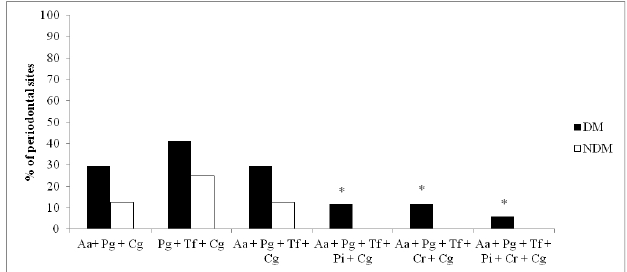
Fig. 3 - Frequency of periodontal sites (%) harboring combinations of putative periodontopathogens with Candida glabrata (Cg) in the DM and NDM groups. *Statistically significant differences between the DM and NDM groups, according to χ2 tests (p <0.05). Aggregatibacter actinomycetemcomitans (Aa), Porphyromonas gingivalis (Pg), Tannerella forsythia (Tf), Prevotella intermedia, Campylobacter rectus